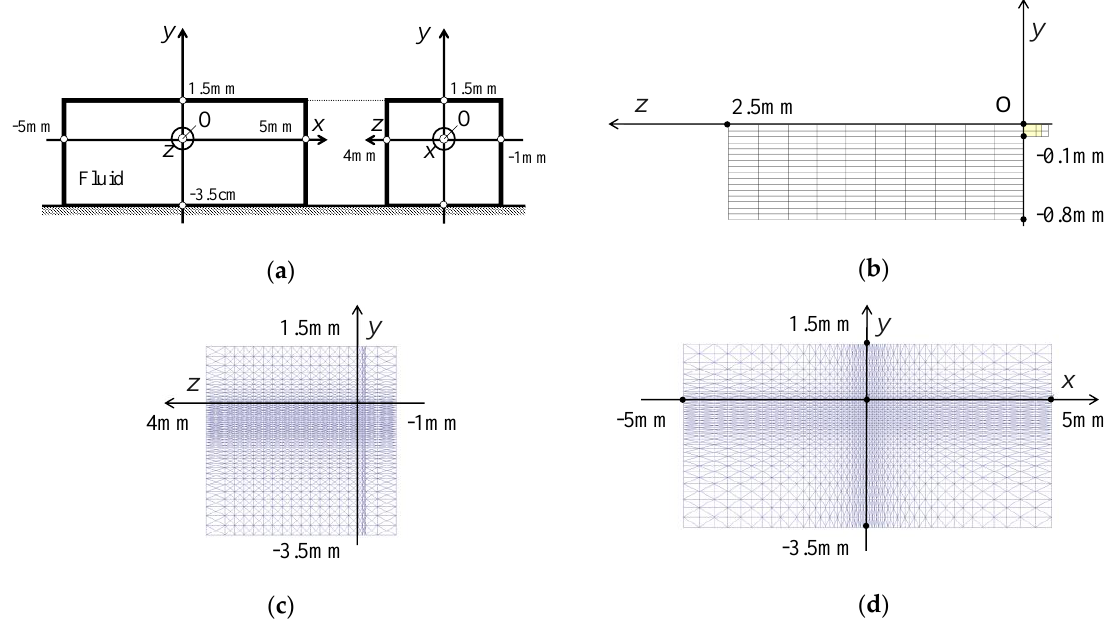
Figure 13. Geometry of the fluid domain and the employed meshes: ( a ) The geometry of the fluid domain; ( b ) The yz -plane view of the wing’s mesh, where the domain colored by yellow is the plate spring; ( c ) The yz -plane view of the fluid domain; ( d ) The xy -plane view of the fluid domain.